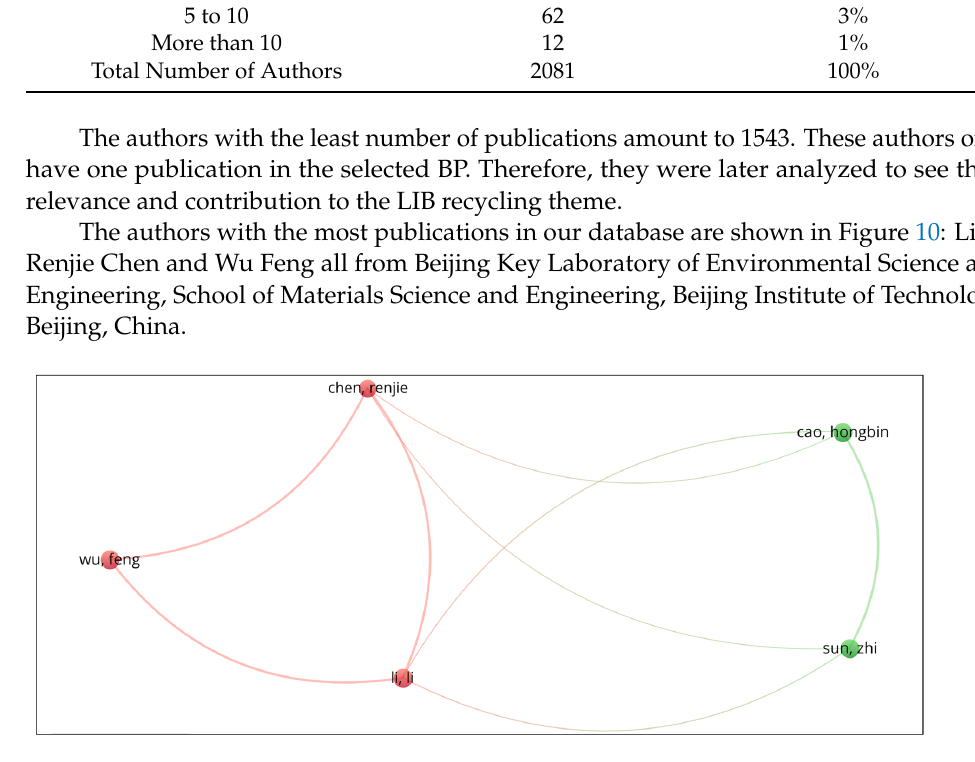
Figure 10. Authors with the greatest number of published articles in LIB recycling bibliographic portfolio—VOS Viewer Network Visualization.